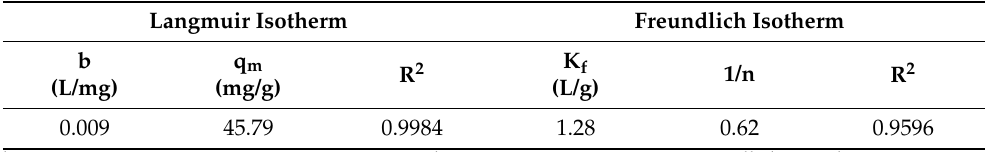
Table 1. Langmuir and Freundlich isotherms constants and values of R 2 for the adsorption of AlgL on BC